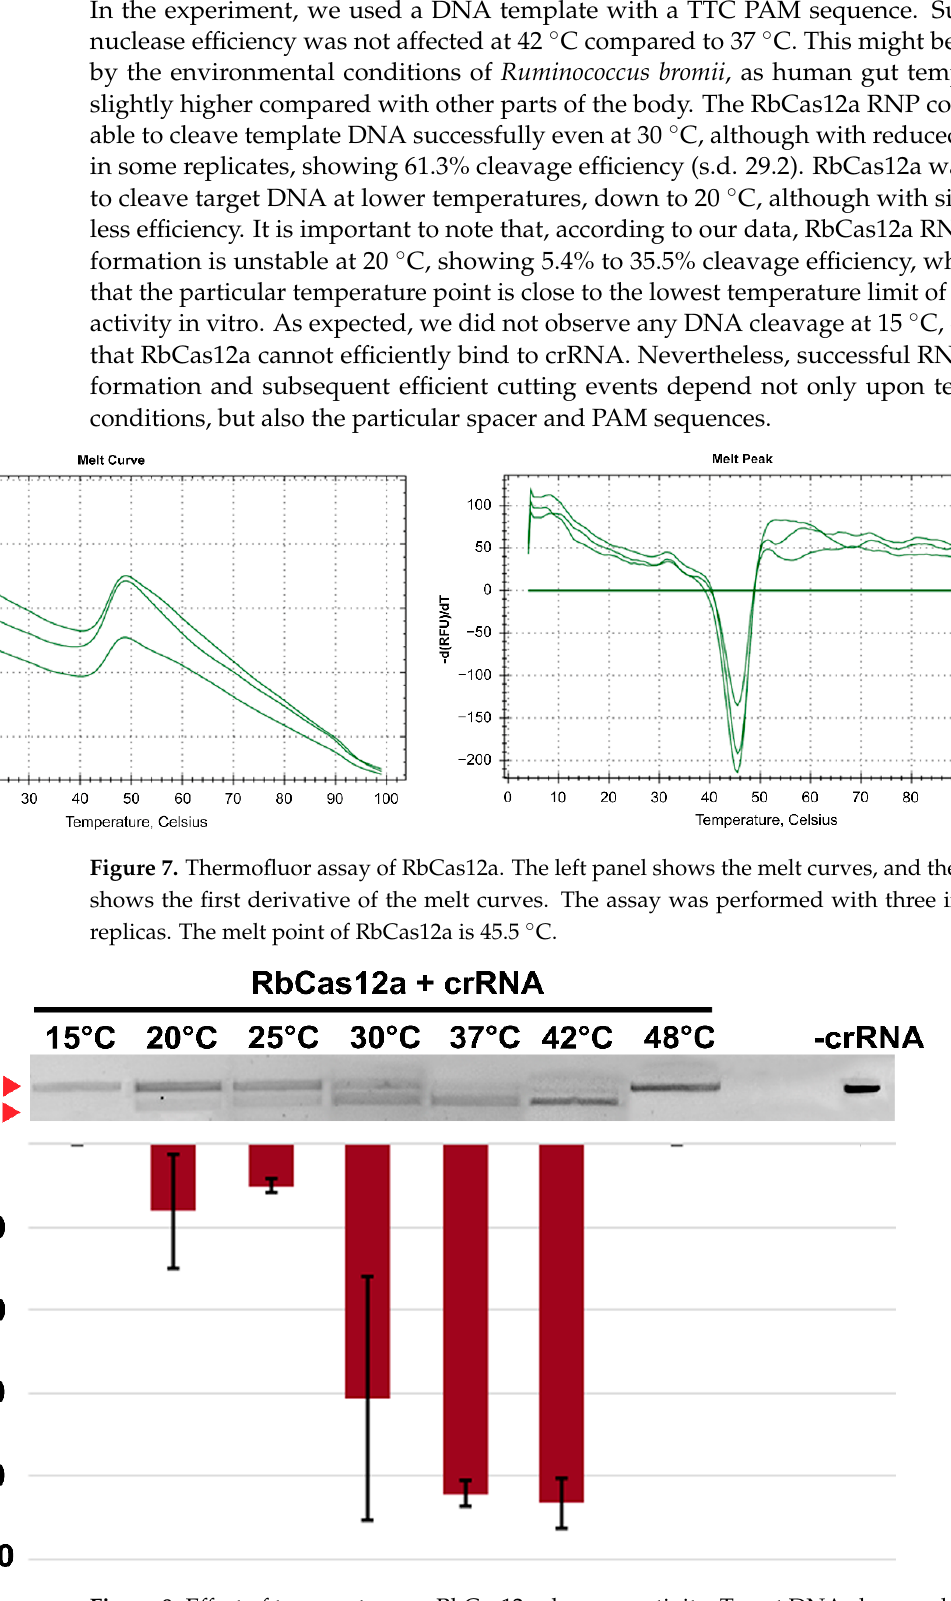
Figure 8. Effect of temperature on RbCas12a cleavage activity. Target DNA cleavage by RbCas12a programed with 500 nM crRNA at 1:3:30 target:Cas12a:RNA ratio. Mean cleavage efficiencies and standard deviations calculated from three independent experiments are shown.